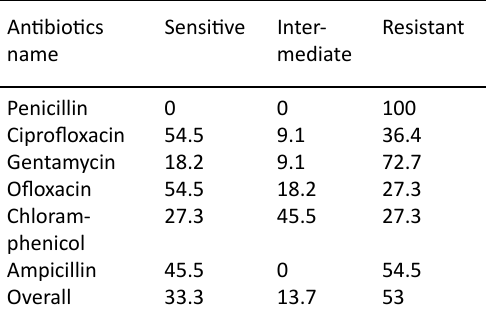
Table 3. Percentage of isolated bacterial antibiogram profile